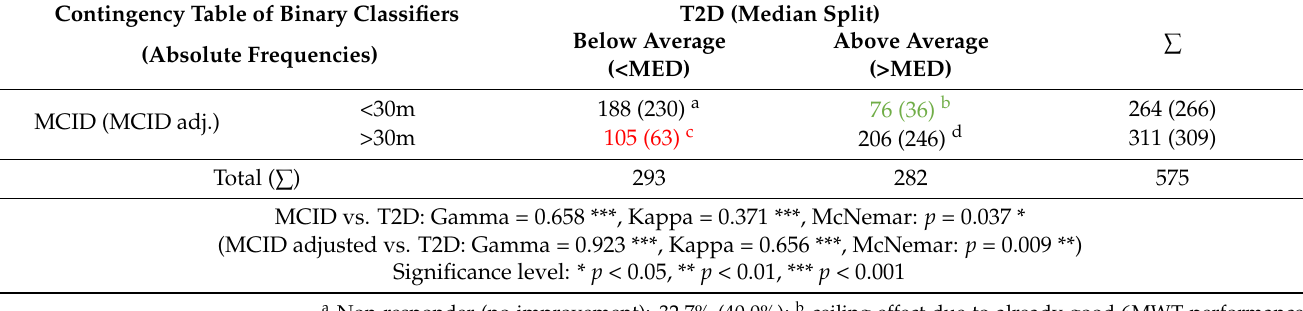
Table 3. Assessment of changes in endurance performance with MCID classification vs. T2D classification. Contingency Table of Binary